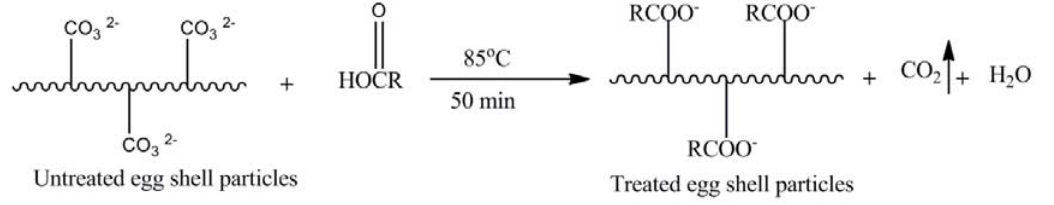
Figure 1. FTIR spectra of UES and TES particles.